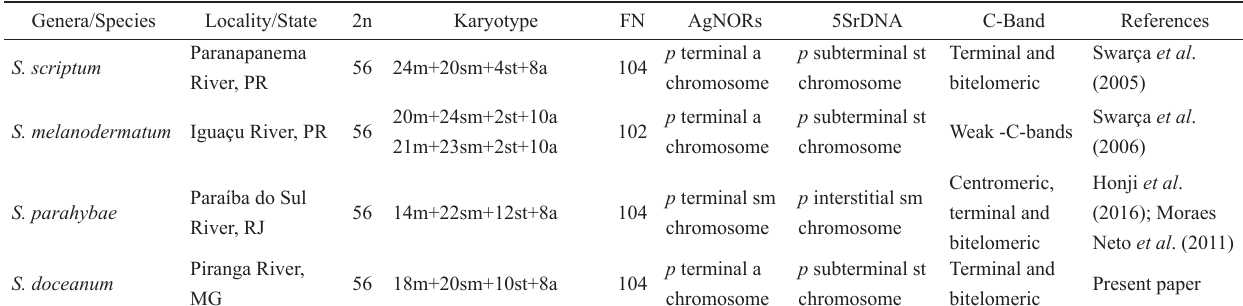
Tab. 1. Karyotype characteristics of the studied species of the genus Steindachneridion . 2n = diploid number; FN = fundamental number; m = metacentrics; sm = submetacentrics; st = subtelocentrics; a = acrocentrics, PR = Paraná state, RJ = Rio de Janeiro State, MG = Minas Gerais State; p = short